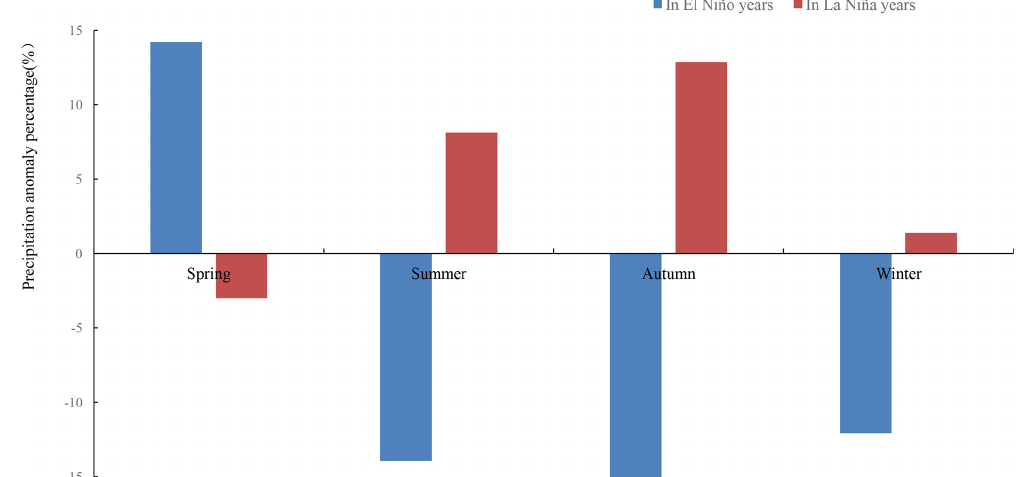
Figure 5. The average precipitation anomaly percentage for each season under the conditions of El Niño and La Niña in the Yellow River